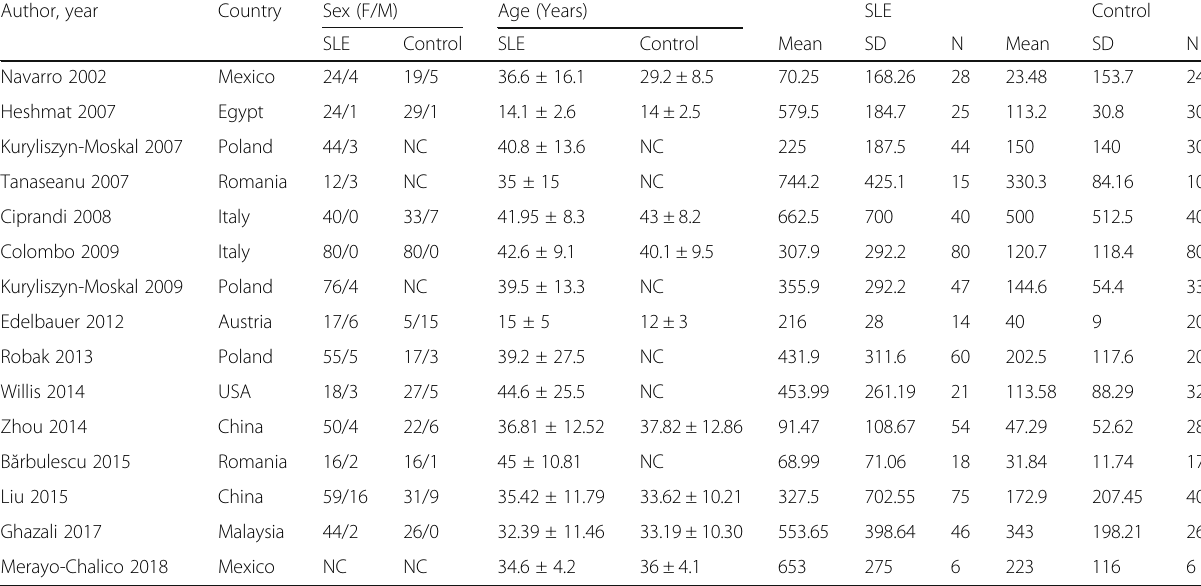
Table 1 characteristics of the studies for the relationship between VEGF levels (pg/ml) and SLE risk